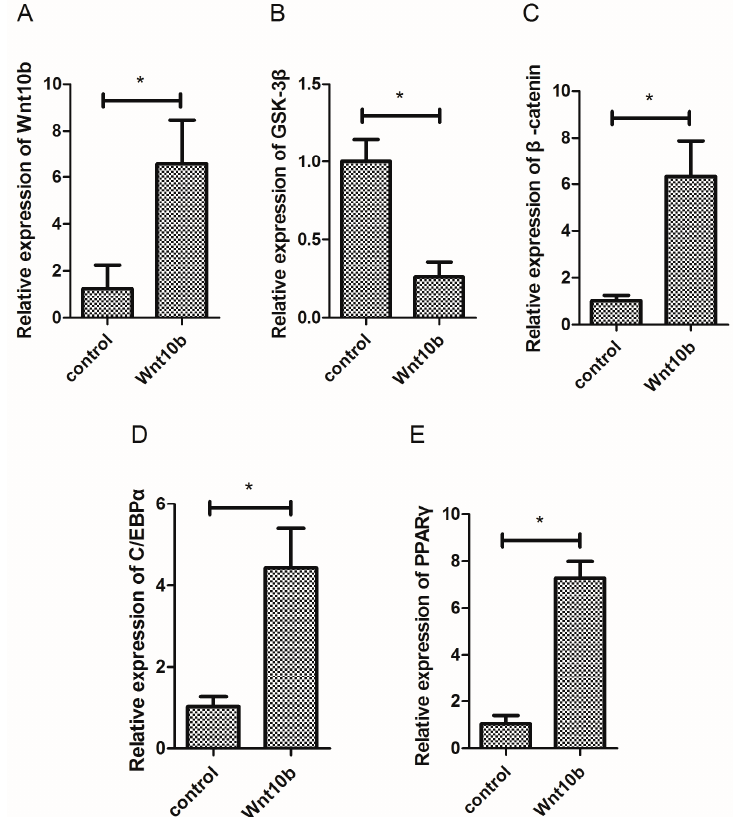
Figure 1. E ff ect of Wnt10b gene overexpression on the mRNA expression of Wnt10b, GSK-3 β , β -catenin, C / EBP α , and PPAR γ in the muscle of zebrafish. ( A ) Wnt10b; ( B ) GSK-3 β ; ( C ) β -catenin; ( D ) C / EBP α ; ( E ) PPAR γ . Values are expressed as means ± s.e.m. ( n = 4). Statistically significant di ff erences are denoted by an asterisk (* p < 0.05).